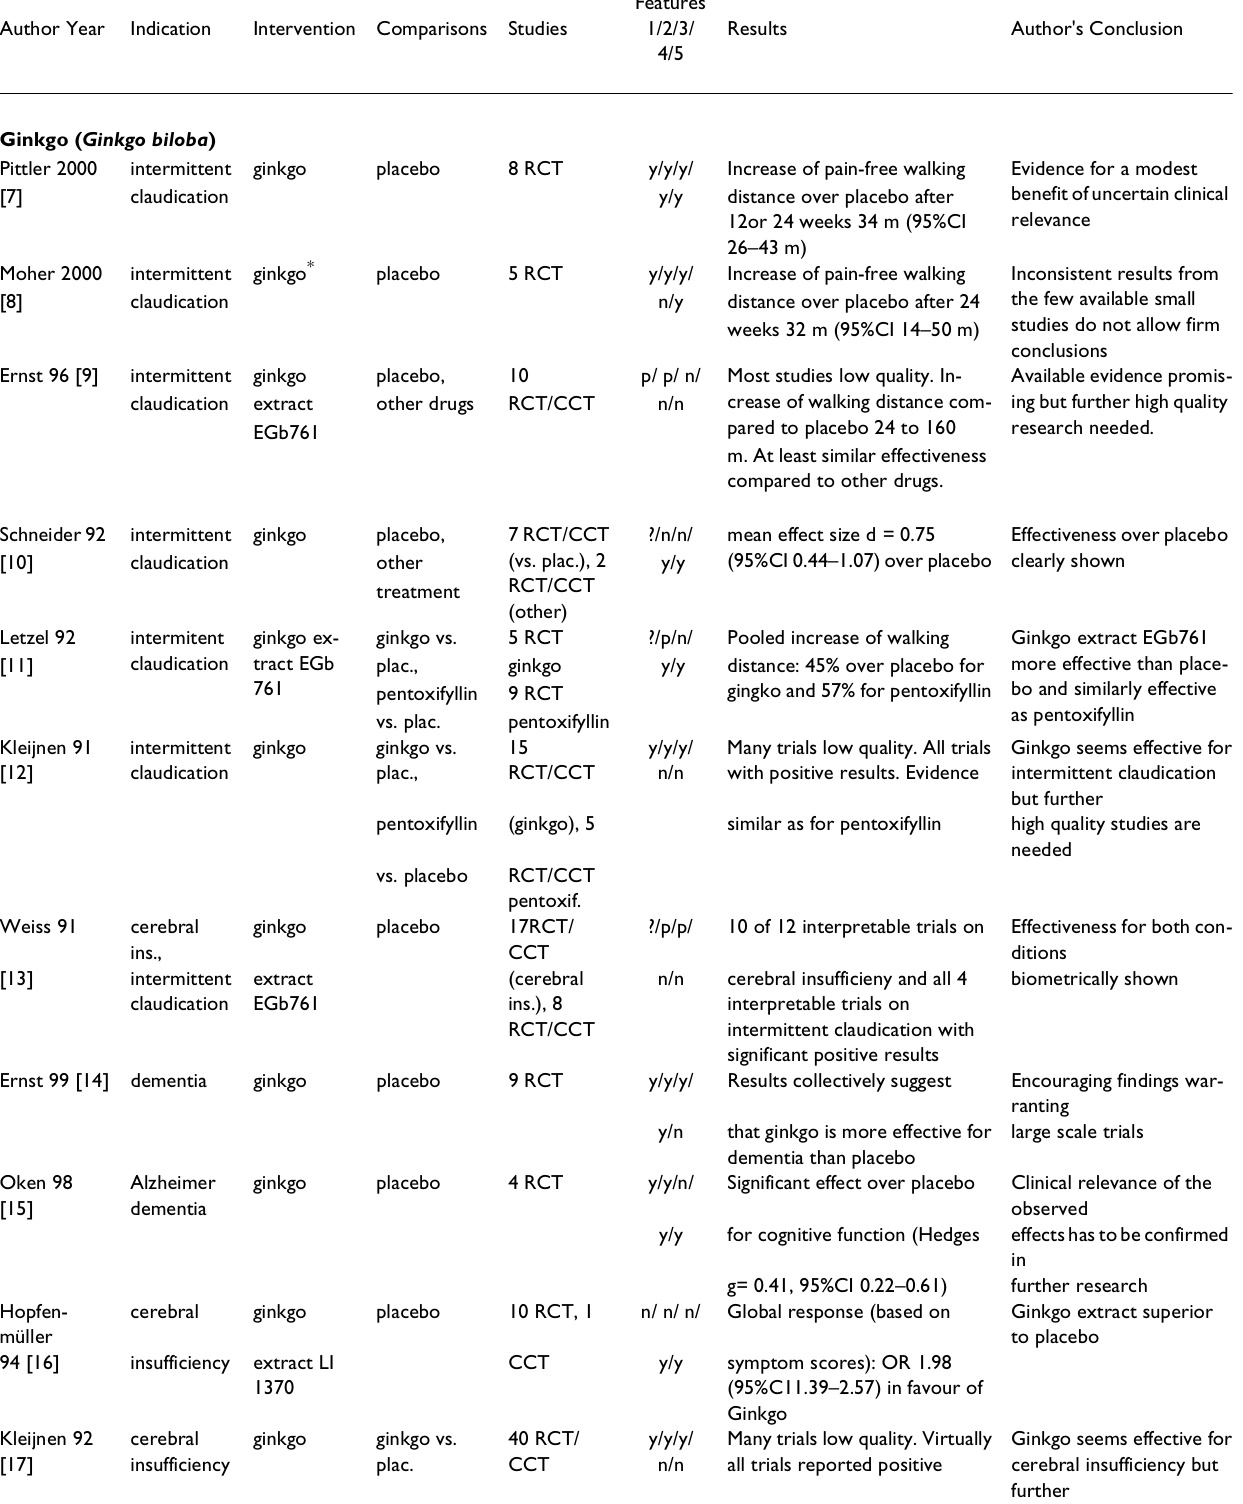
Table 1: Systematic reviews of clinical trials of ginkgo biloba